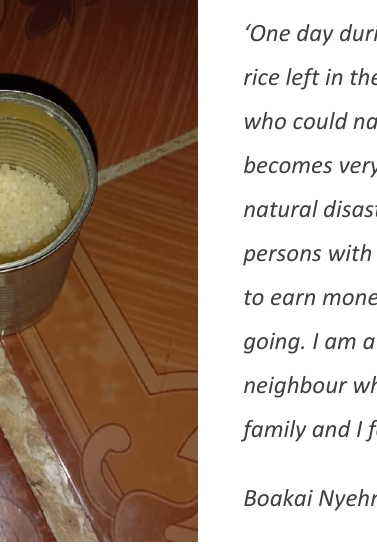
Figure 1. Alt-text: A tin half-filled with rice grains.